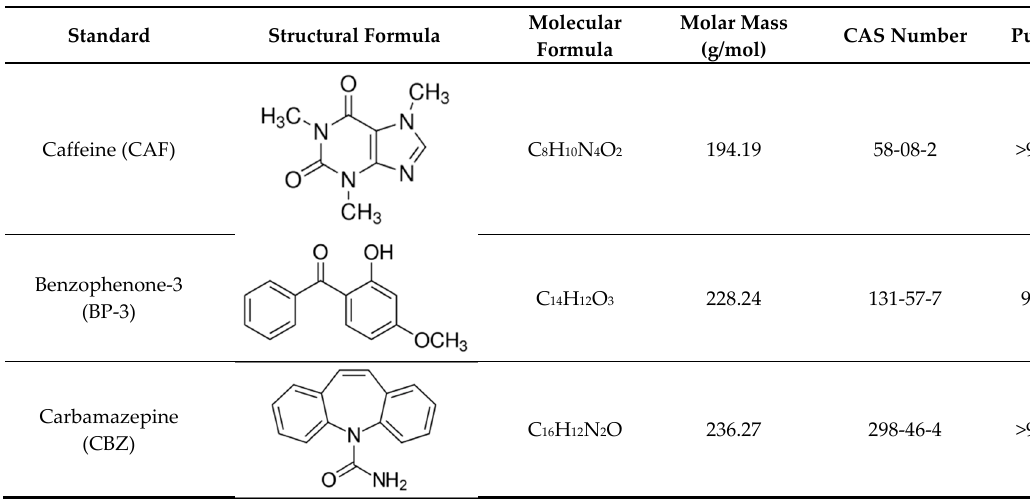
Table 1. Characteristics of tested compounds.